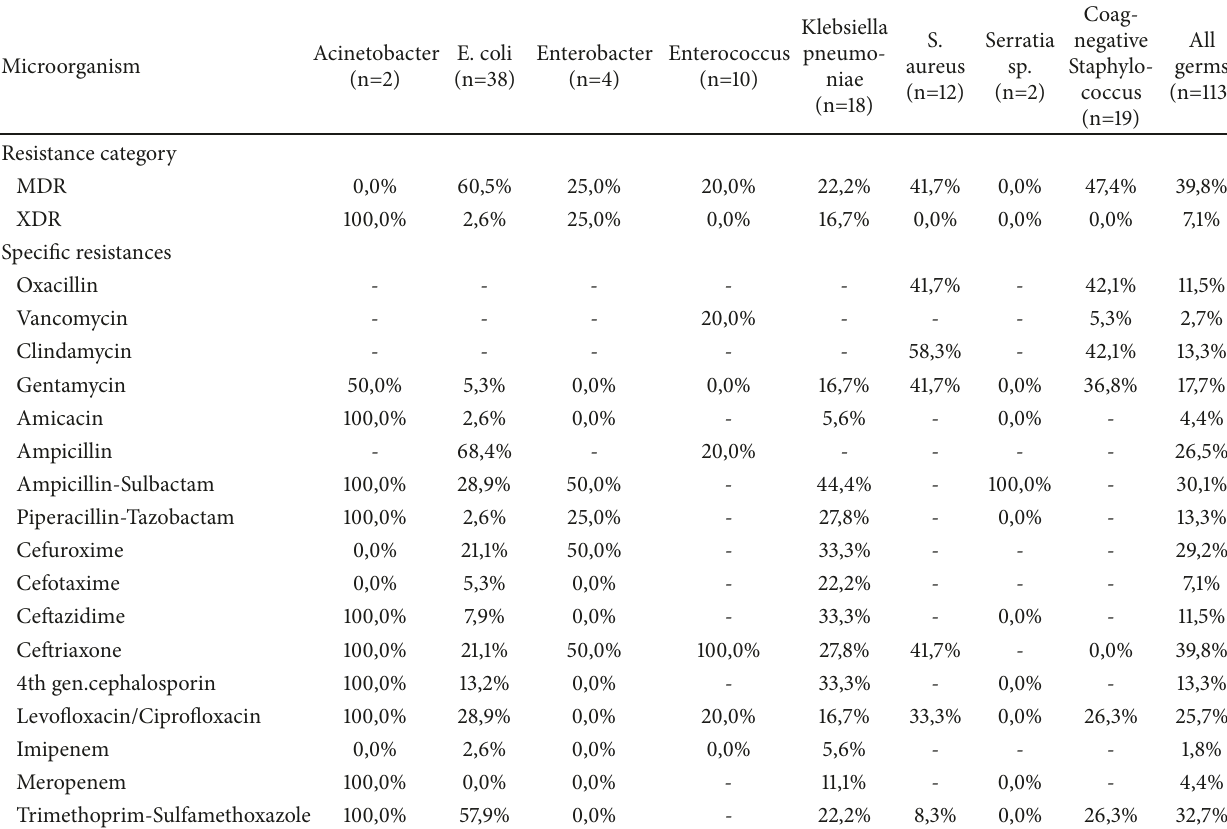
Table 3: Bacterial resistances of most prevalent germs against specific antibiotics among SBP-related cultures.